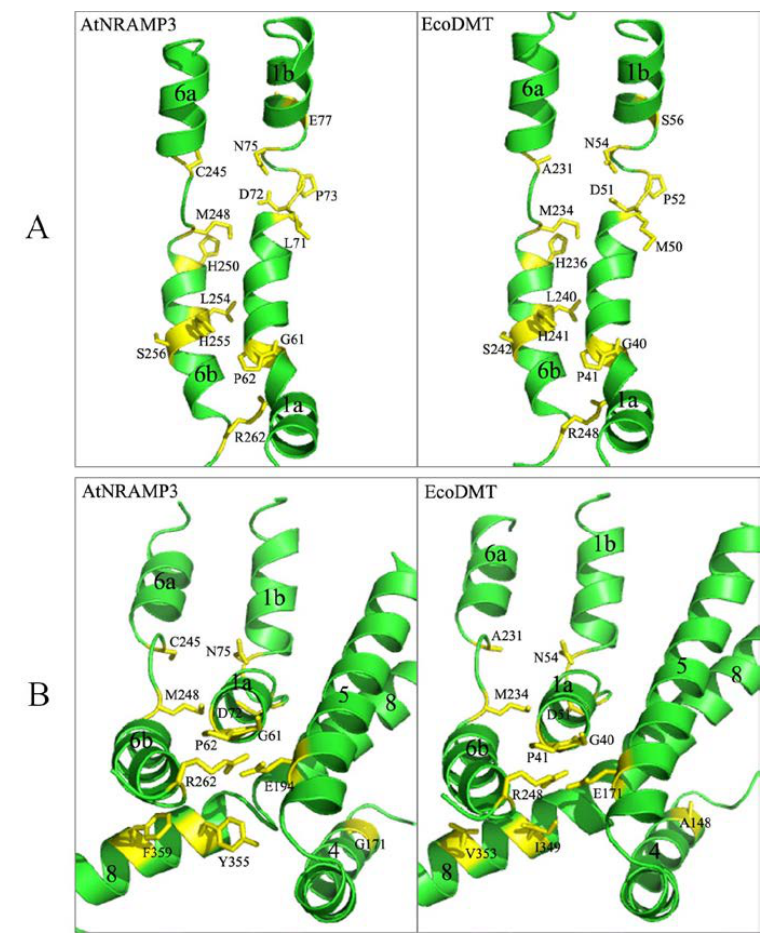
Figure 8. Residues with relevant roles in the transport activity of AtNRAMP3 ( left ) and the corresponding residues on the crystal structures of EcoDMT ( right ). ( A ) Residues located within α -helices 1 and 6 that affect transport activity are shown as sticks. ( B ) Some residues distal to the ion-binding site and necessary for transport activity are located on α -helices 4, 5 and 8.